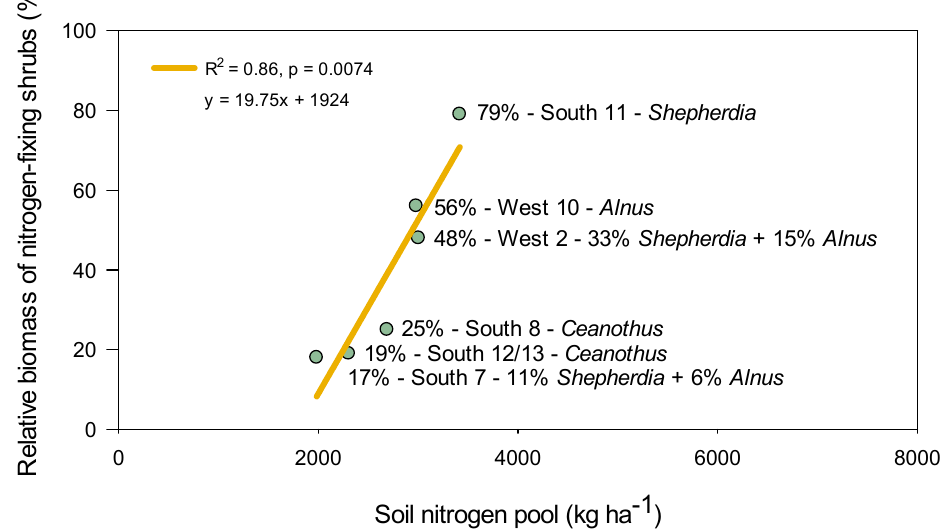
Figure 11. The relationship between the relative biomass of nitrogen-fixing shrubs ( Alnus viridis ssp. sinuata , Ceanothus velutinus , and Shepherdia canadensis ) and the soil nitrogen pool for 30-year-old disturbances in the Xerophyllum tenax (XETE) habitat type phase within the Abies lasiocarpa / Clintonia uniflora habitat type. See Table 1 for disturbance category descriptions.